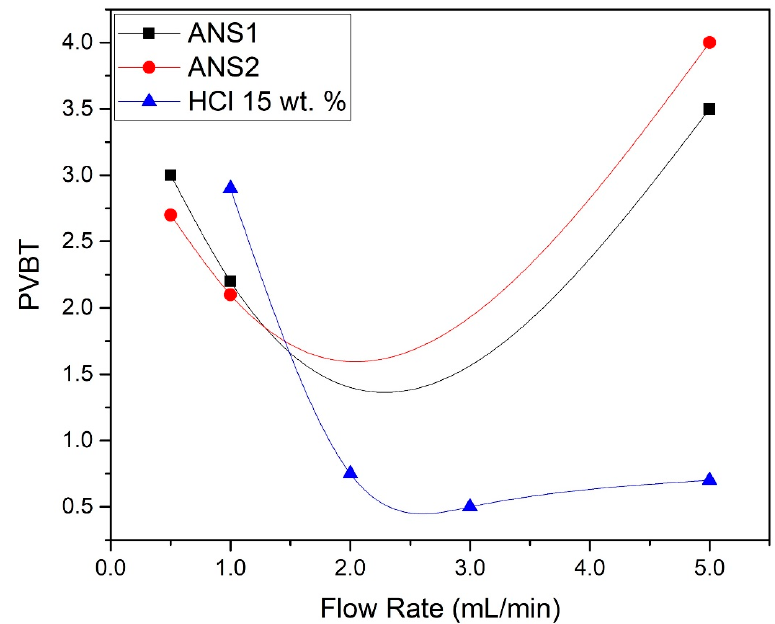
Figure 1. PVBT (pore volume to breakthrough) for ANS1, ANS2, and HCl 15.0 wt. %.